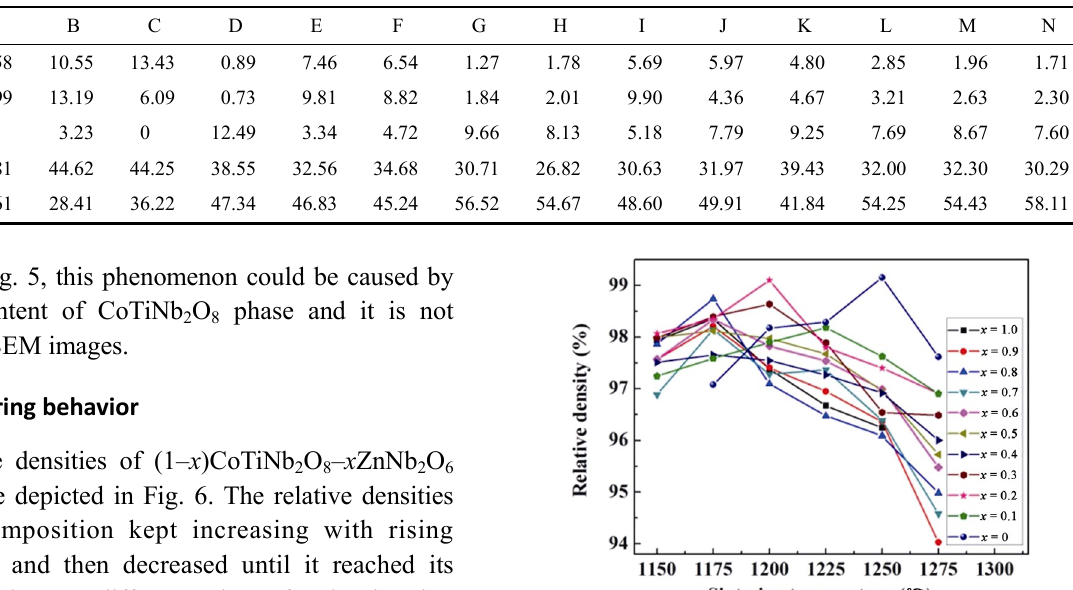
Fig. 5 SEM images of (1– x )CoTiNb 2 O 8 − x ZnNb 2 O 6 ceramics with x = (a) 0, (b) 0.1, (c) 0.2, (d) 0.3, (e) 0.4, (f) 0.5, (g) 0.6, (h) 0.7, (i) 0.8, (j) 0.9, and (k) 1 sintered at 1175 ℃ for 4 h. Table 3 EDS analysis of (1– x )CoTiNb 2 O 8 − x ZnNb 2 O 6 ceramics marked in Fig. 5 (Unit: